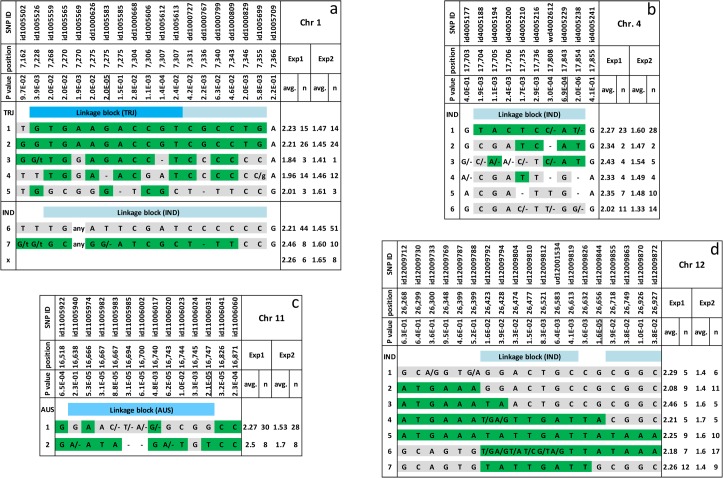
Haplotype analysis for main loci associated with PUE on chromosomes 1 (A), 4 (B), 11 (C), and 12 (D).Within haplotypes most significant SNPs highlighted in bold print and average PUE values of accessions belonging to respective haplotype are given. SNP alleles improving PUE are highlighted in green while negative alleles are highlighted grey. Linkage blocks for the respective subpopulation are indicated in blue above the haplotypes (see S5 Fig for details on LD analysis).